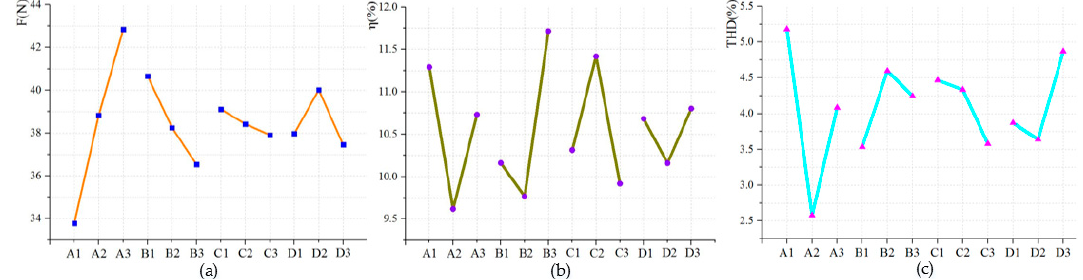
Figure 5. Main factor effects on motor performances: ( a ) F (N); ( b ) η (%); and ( c ) THD (%).